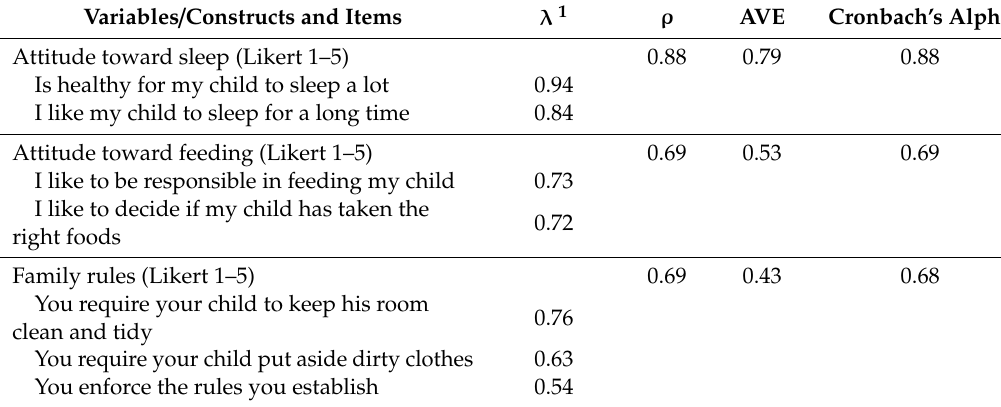
Table 2. Multi-item scales and reliability.